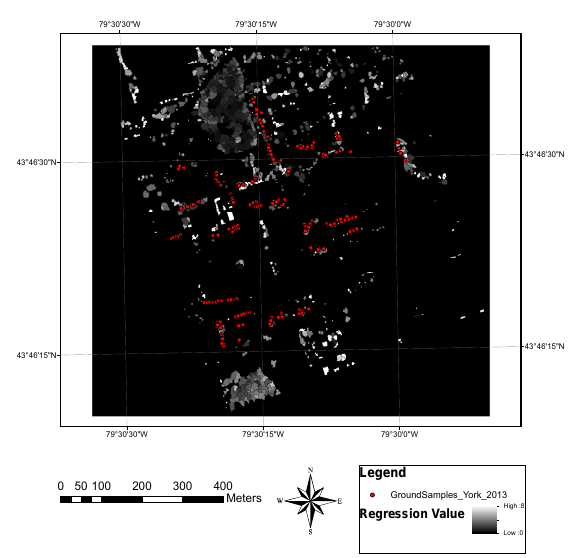
Figure 5. The regression value of the classes of tree species, together with the locations of the sampled ash trees.